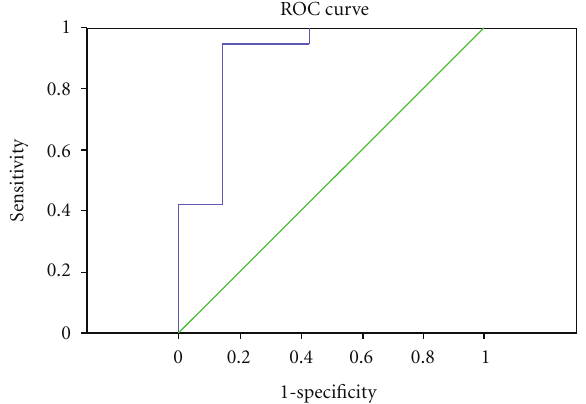
Figure 8: ROC of diagnosis model for clinical staging (AUC = 0 . 902).